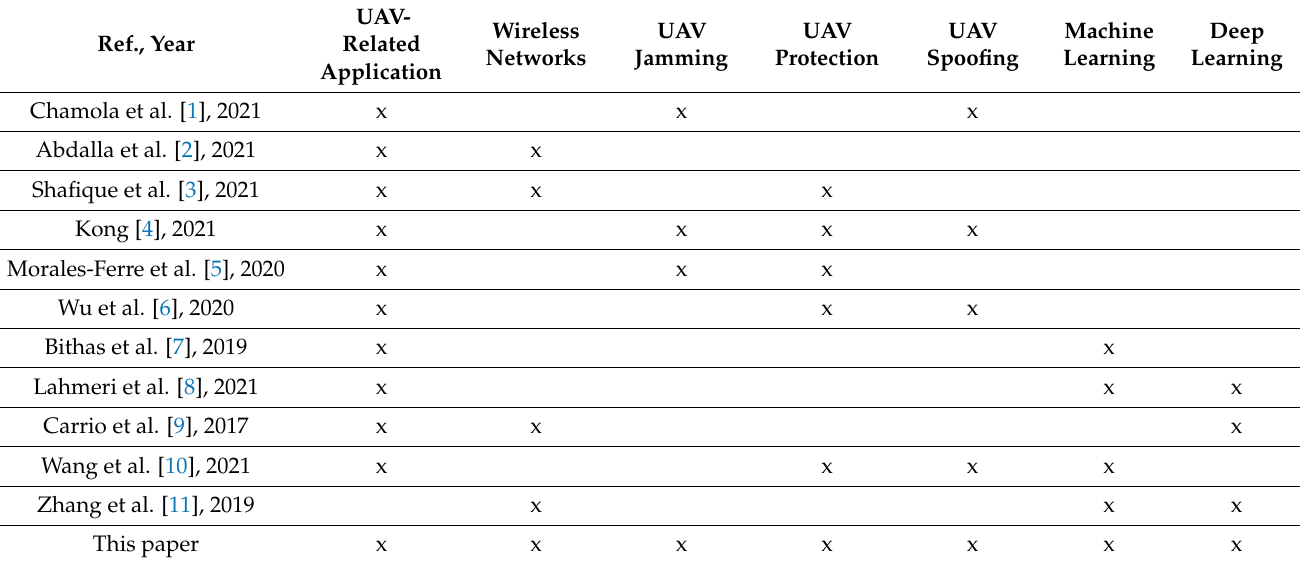
Table 1. Relevant surveys and reviews on various UAV-related